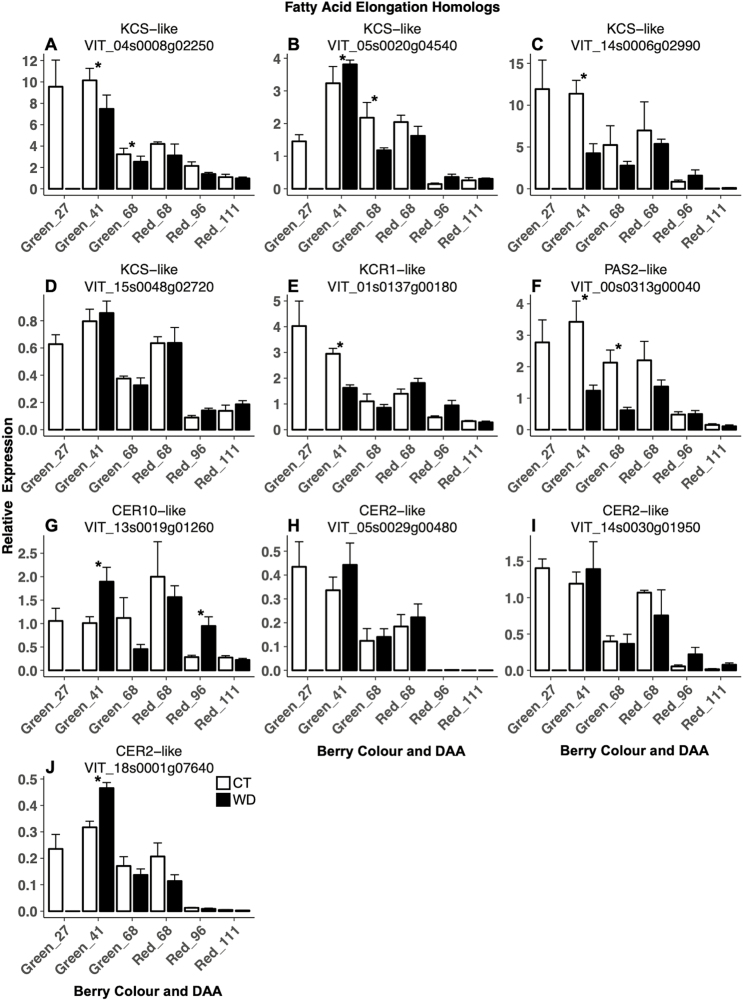
Expression of candidate genes involved in the fatty acid elongation of the biosynthetic cuticular wax pathway in berry skins of grapevines (Vitis vinifera L.) exposed to two irrigation treatments: well-irrigated (control, CT) and deficit irrigated (water deficit, WD). Error bars represent ±SE, and significant differences between treatments were determined by two-sample t-test (*P<0.05).